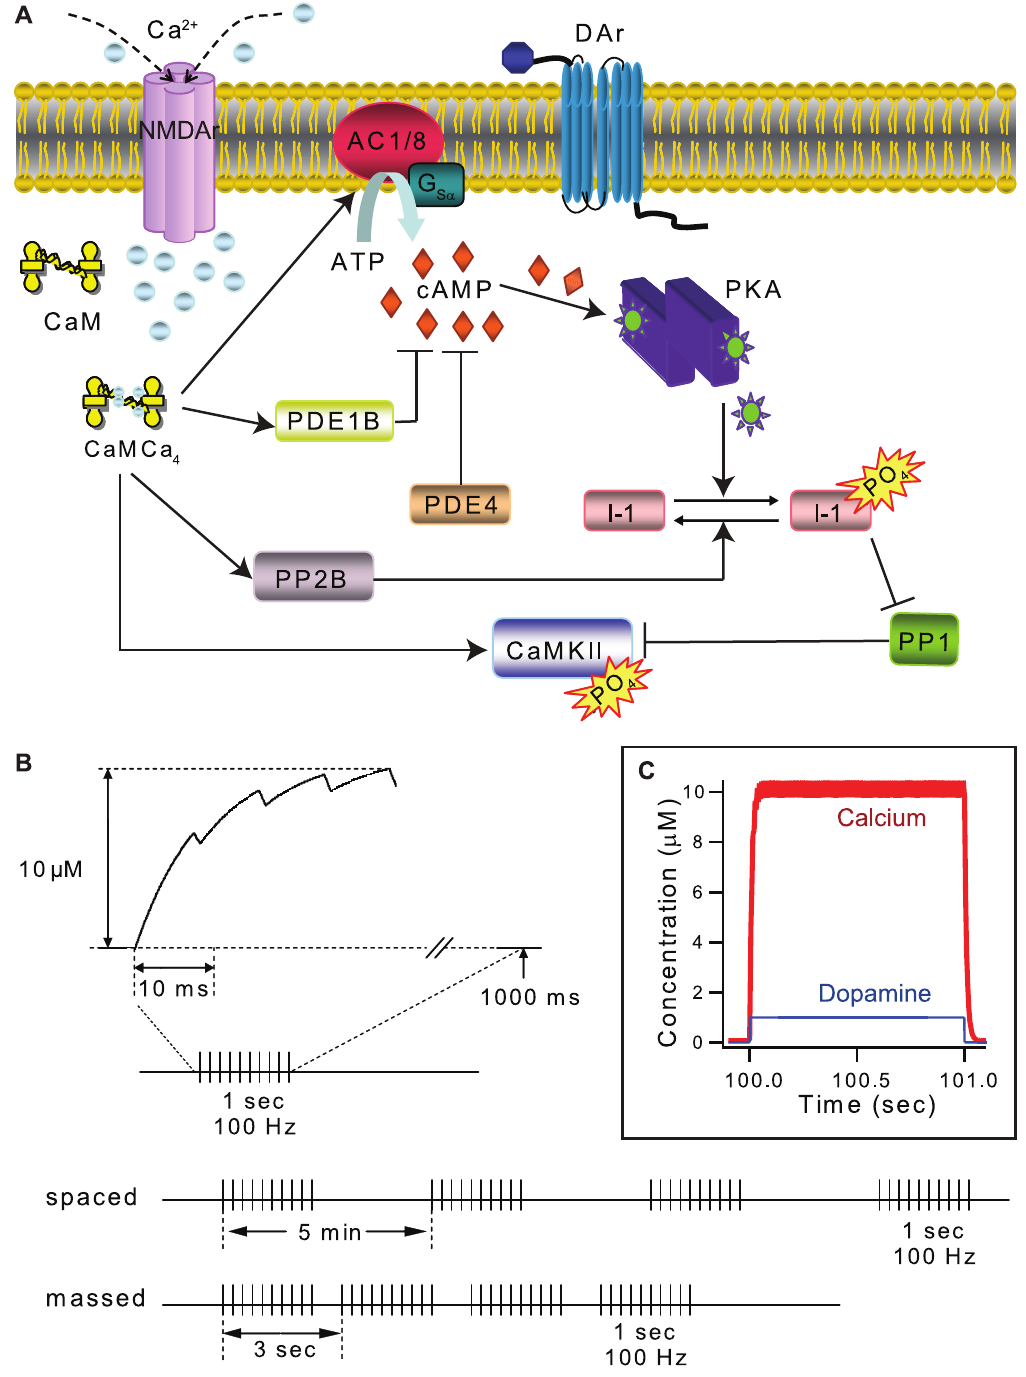
Figure 1. Model of L-LTP induction in hippocampal CA1 pyramidal neurons. (A) Signaling pathways in model activated by pre-synaptic stimulation. Calcium (from glutamate activation of NMDA receptors) binds to Calmodulin (CaM). Calcium-calmodulin can bind to and activate protein phosphatase 2B (PP2B), adenylyl cyclase types 1 and 8 (AC), phosphodiesterase type 1B (PDE1B), or CaMKII. Gs-coupled receptors, such as dopamine D1 and b -adrenergic receptors, synergistically activate adenylyl cyclase, which produces cAMP, which binds to PKA. Two types of phosphodiesterase (PDE1B and PDE4) degrade cAMP leading to PKA de-activation. Active PKA phosphorylates inhibitor-1 (I1), which then binds to and inhibits protein phosphatase 1 (PP1). CaMKII can autophosphorylate itself, and is dephosphorylated by PP1. (B) Stimulation protocols used for induction of L-LTP in the model. A single Ca 2 + pulse rises instantaneously to an amplitude of 0.7 m M and decays with a time constant of 0.14 sec. Summation of Ca 2 + pulses in the train gives a maximum elevation of Ca 2 + of , 10 m M (top panel). A spaced pattern consisted of four 100 Hz trains (each 1 sec duration and fixed total number of pulses (400)) with an inter-train interval of 300 sec. The massed pattern provides the same four 100 Hz trains, but with an inter-train interval of 3 sec. Time intervals shown are not to scale. (C) Simulated time course of Ca 2 + and dopamine input for a single 1 sec train of synaptic input at 100 Hz with the magnitude of 10 m M and 1 m M respectively.